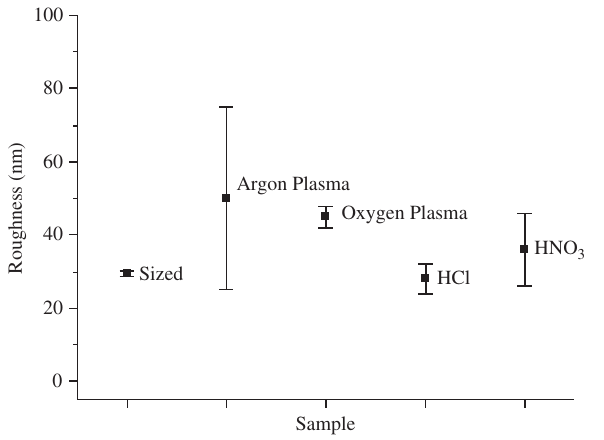
Figure 4. Correlation between the average surface roughness values and the superficial treatments applied to the carbon